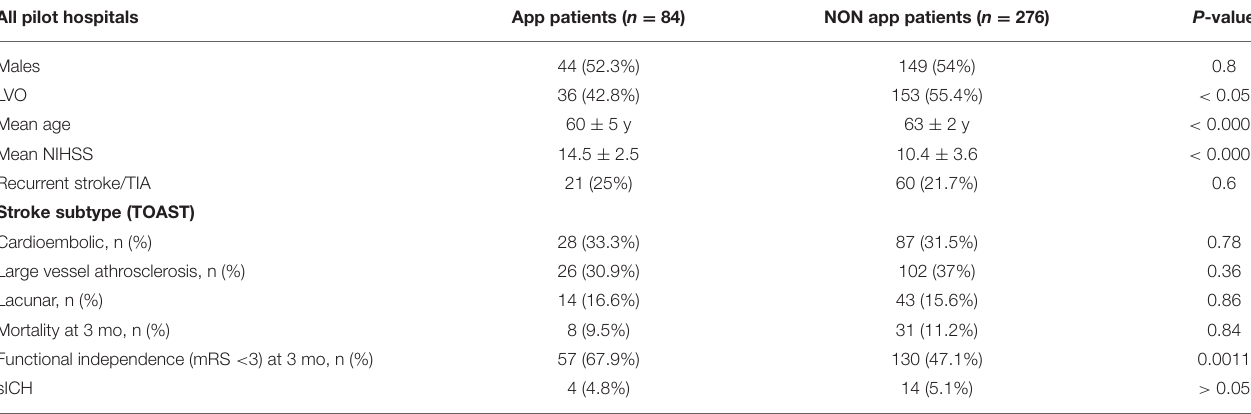
TABLE 2 | Characteristics of patients entered into the registry. All pilot hospitals